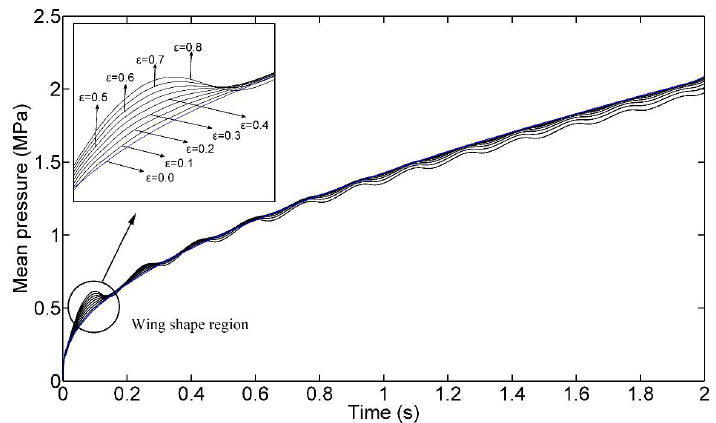
Figure 10. Time domain curves of the mean filling pressure. Polymers 2017 , 9 , 85